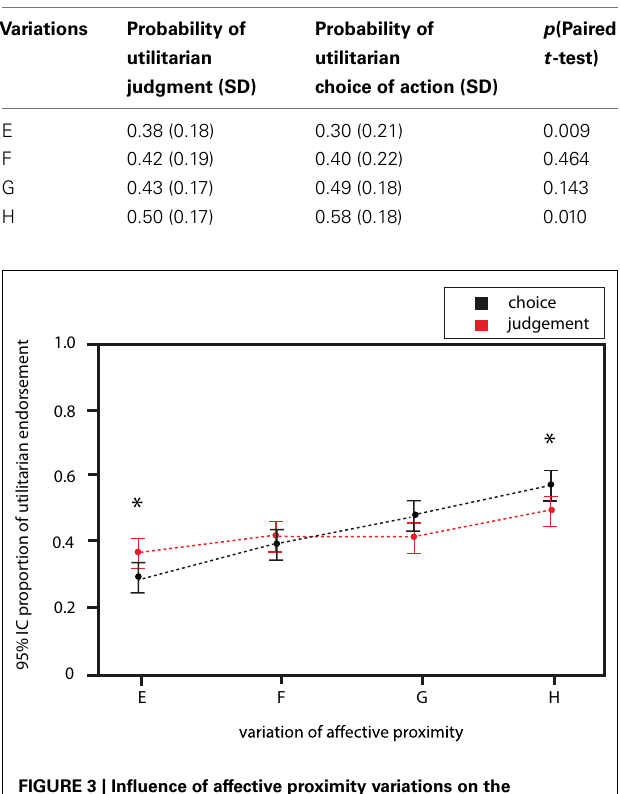
FIGURE 3 | Influence of affective proximity variations on the probability of utilitarian response in both conditions .